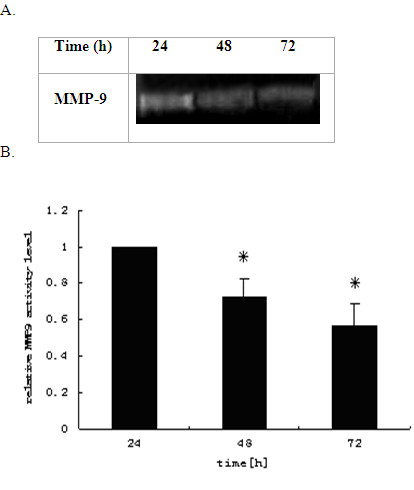
Time-dependence of the ASA inhibition of MMP-9 activities released to media from THP-1 macrophages. The THP-1 macrophages were cultured in media containing 10% FBS with ASA at 600 uM for 24 h, 48 h and 72 h, and the activities of MMP-9 were measured by gelatin Zymography (A). Signal intensities from the zymographs were analysed by the Quantity One software and transformed to the bar graph (B).Results are expressed as mean ±S.D, of three experiments with duplicated samples. * P < 0.05,compared to control.